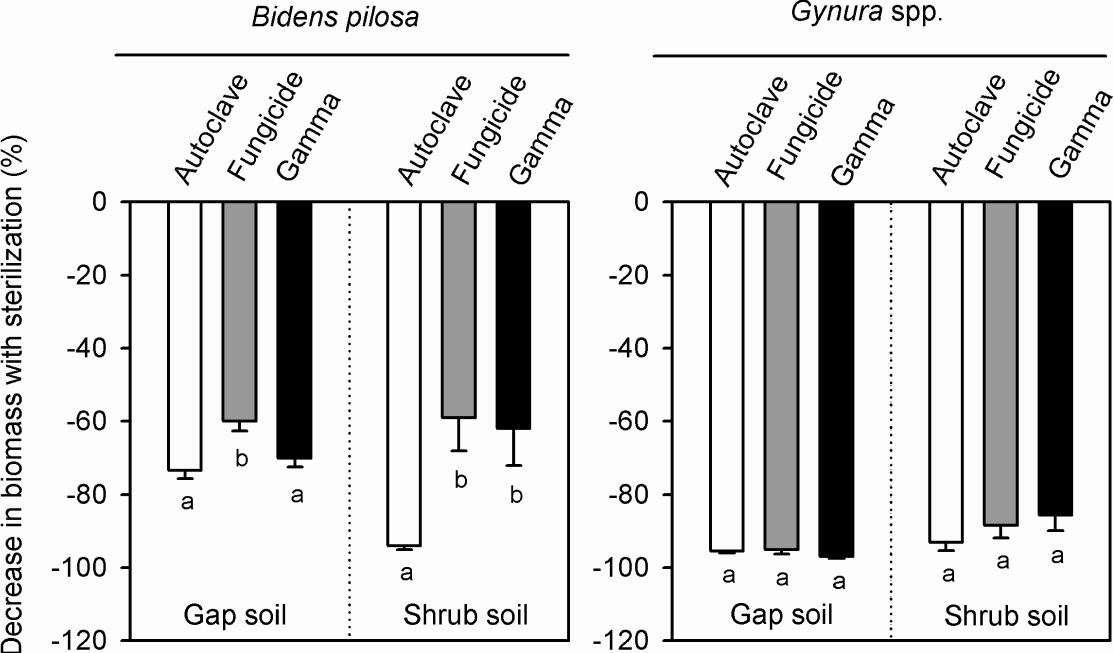
Figure 2. Decrease in total biomass with biocides in Bidens pilosa and Gynura spp. Data are means + 1 SE (n = 9). The decrease in total biomass was calculated according to the following equation: